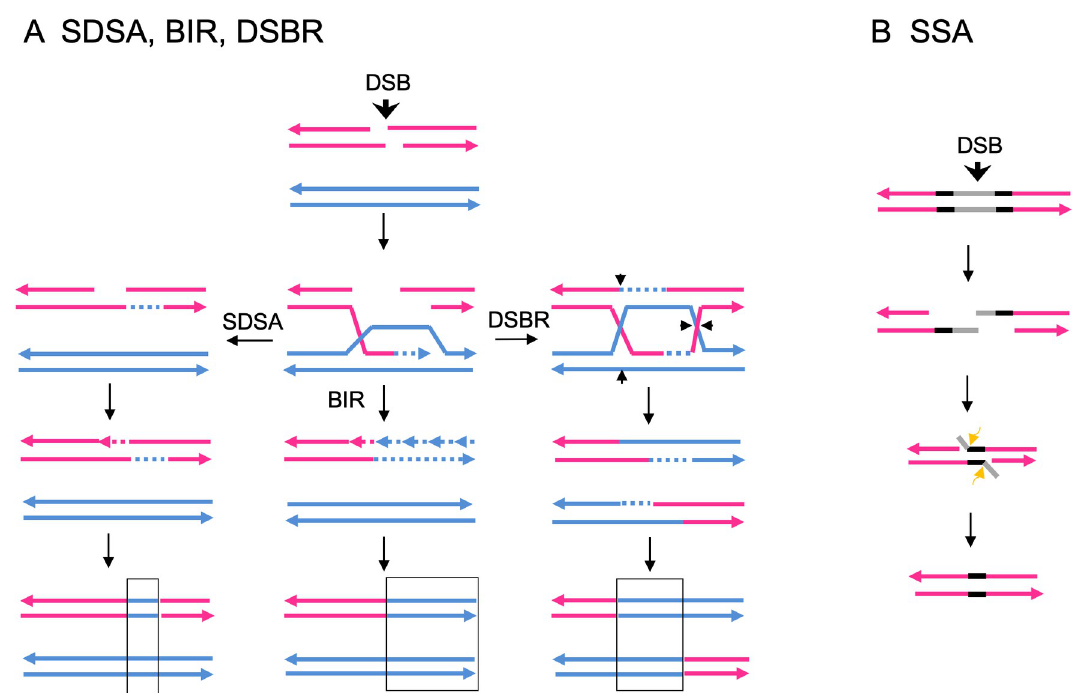
Fig 2. Pathways of homologous recombination. (A) Repair of a double-strand break (DSB) by synthesis-dependent strand annealing (SDSA), break-induced replication (BIR), and double-stranded break repair (DSBR). All pathways are initiated by a DSB shown by the vertical arrow, followed by 5’ to 3’ resection of the broken ends; the 3’ ends of the strands are marked with an arrow. The 3’ single-strand of one broken end invades the unbroken chromosome. DNA synthesis (dotted line) displaces a strand from the unbroken template. In the SDSA pathway, the invading strand is displaced and re-pairs with one of the broken ends. Mismatch repair of the heteroduplex (duplex formed from red and blue strands) results in a region of gene conversion (boxed) in which the flanking sequences are in the original parental configuration. In the BIR pathway, one of the broken products of the “red” chromosome is lost, and replaced by DNA synthesis from the unbroken template. This conservative synthesis involves the use of the blue strand as a template for one strand (continuous dotted line), and the new strand as a template for synthesis of the second strand (multiple short fragments with dotted lines). The net result of this process is a non-reciprocal LOH event that may extend to the end of the chromosome. The DSBR pathway is characterized by pairing between the displaced blue single-strand and one of the broken red strands. The resulting double-Holliday junction is resolved by cleaving the strands that connect the two duplexes. If the strands are cut as shown by the short arrows, the resulting duplexes have a region of conversion flanked by sequences in the recombinant configuration. It should be pointed out that extensive strand resection from the DSB may allow the recombination breakpoint to be displaced from the location of the DSB by > 10 kb, as observed by Hoang et al . [15]. (B) Single-strand annealing (SSA) pathway. This intrachromosomal pathway is used to repair a DSB located between two repeated sequences (shown in black) that are separated by a region of non-repeated DNA (shown in gray). Resection of both ends exposes homology within the two repeats, allowing pairing. The unpaired single-strands are removed by endonucleases. The net result of this event is loss of one repeat and the intervening non- repeated sequence. Since Ty elements are flanked by 330-bp repeats, loss of the Ty and retention of one delta sequence may reflect the SSA